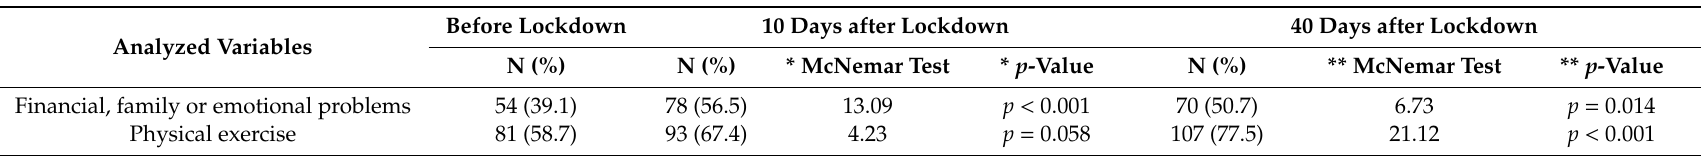
Table 2. Variation in the score of the stress factors and the overall SSI-SM score before lockdown, 10 days after lockdown, and 40 days after lockdown. Factors of the